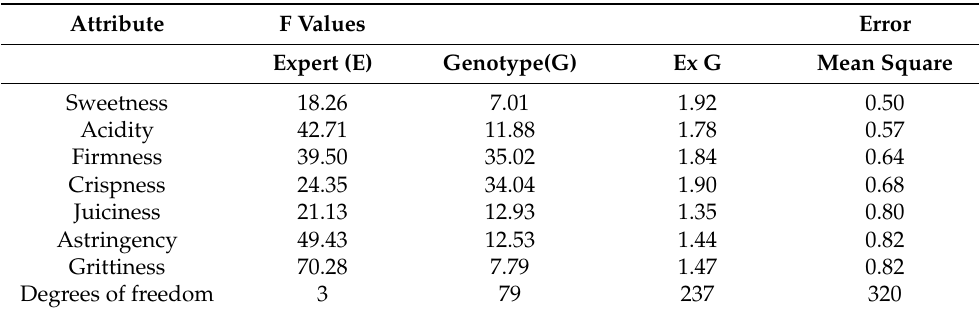
Table 6. Two-way analysis of variance of seven sensory attributes carried out for 4 expert panellists on 80 pear genotypes.